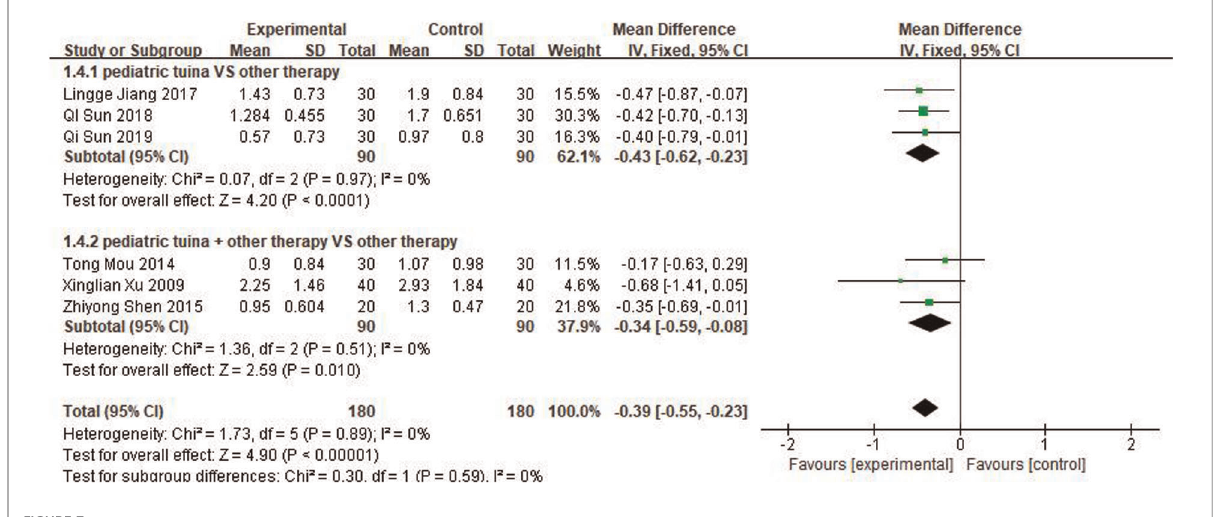
FIGURE 7 Forest plot for the treatment of runny